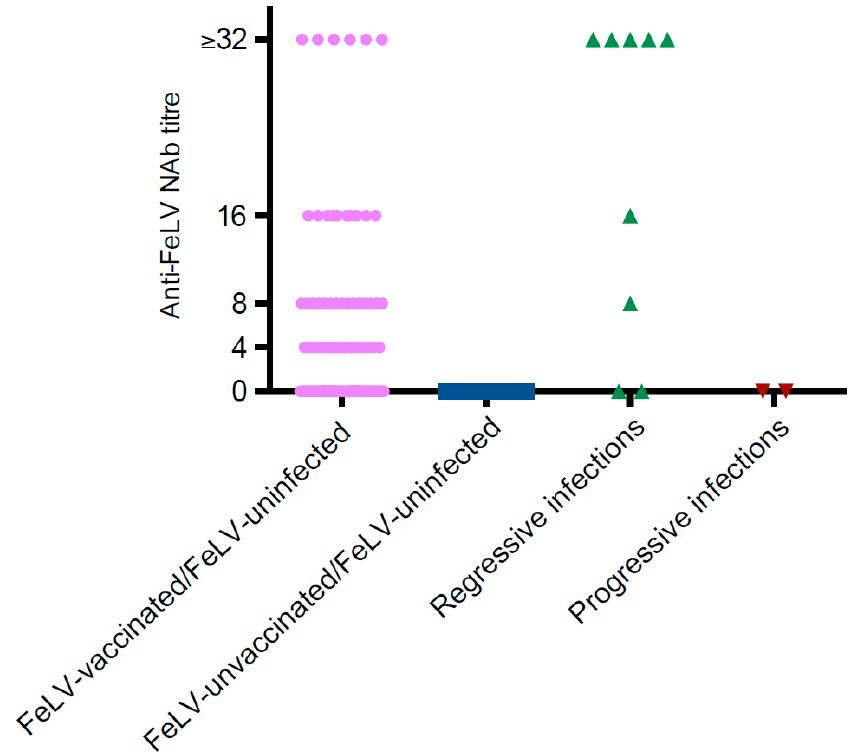
Figure 4. Summary of anti-FeLV NAb results in Group 1 ( n = 428), recorded as the reciprocals of the plasma dilutions that reduced the focus count of FeLV by 75% compared with the virus control that had been incubated without plasma. A NAb titre of 4 was considered weakly NAb-positive, while a titre of 32 was considered strongly NAb-positive. Sufficient sample was available from 131 FeLV- vaccinated/FeLV-uninfected cats, 286 FeLV-unvaccinated/FeLV-uninfected cats, 9 presumptively regressively FeLV-infected cats, and 2 presumptively progressively FeLV-infected cats for NAb testing.